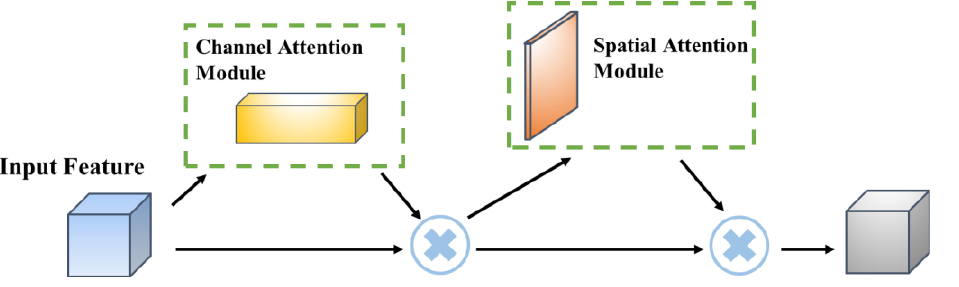
Figure 6. CBAM module structure diagram.